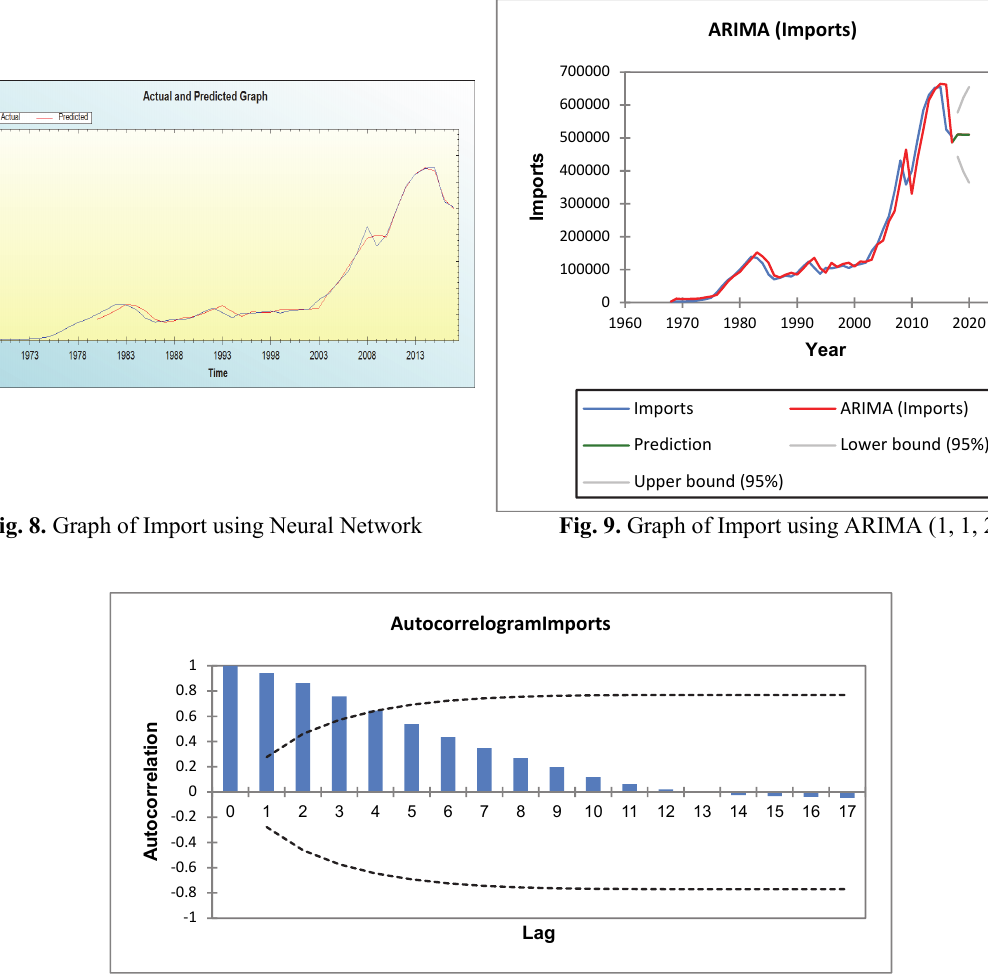
Fig. 10. Plot of ACF of